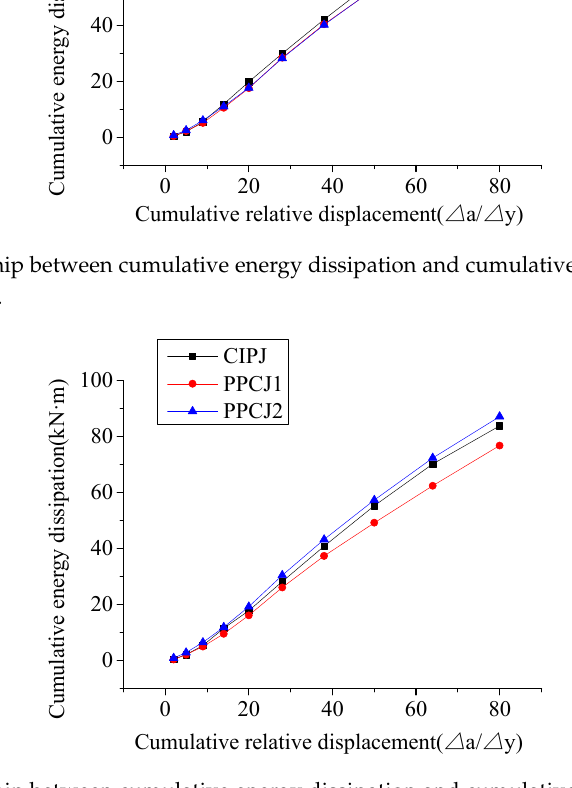
Figure 24. Relationship between cumulative energy dissipation and cumulative relative displacement of the joint right beam.